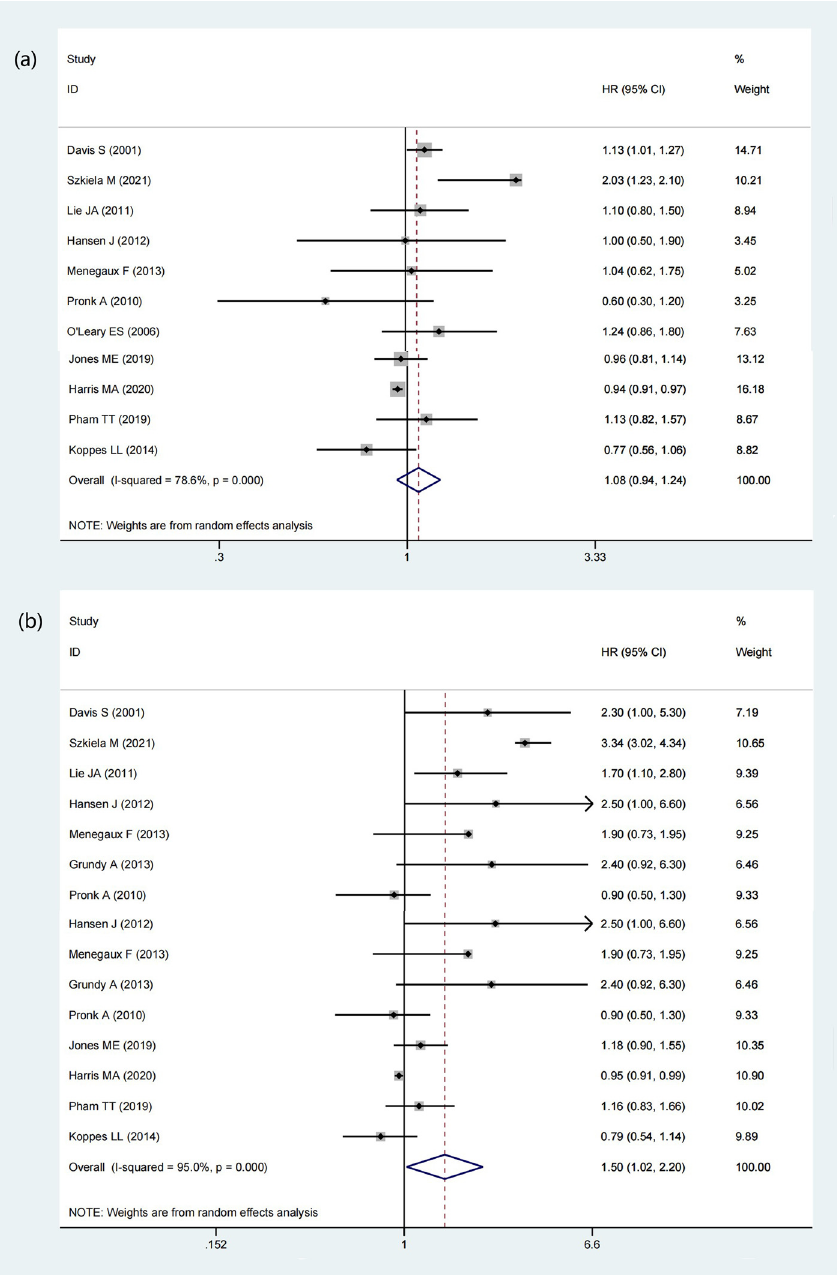
Figure 3: Forest plot describing the association between night shift work frequency and risk of BC. ( a ) 1 – 5 times per week. ( b ) More than 5 times a